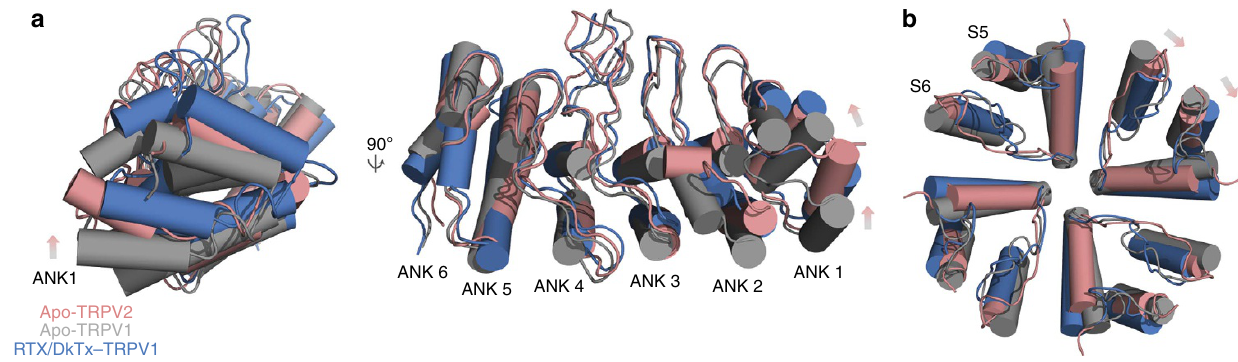
Figure 3 | Comparison of the ankyrin repeat domain and outer pore region of TRPV2 and TRPV1. ( a ) Two representative views of the superimposed ARDs of apo-TRPV1 (grey), RTX/DkTx–TRPV1 (blue) and apo-TRPV2 (salmon). Arrows represent displacement of the apo-TRPV2 ARDs relative to apo-TRPV1. ( b ) Superimposed top–down views of outer pore regions of apo-TRPV1 (grey), RTX/DkTx–TRPV1 (blue) and apo-TRPV2 (salmon). Note the shift in position of the pore helix and S5 in the clockwise direction of both RTX/DkTx–TRPV1 and apo-TRPV2 relative to